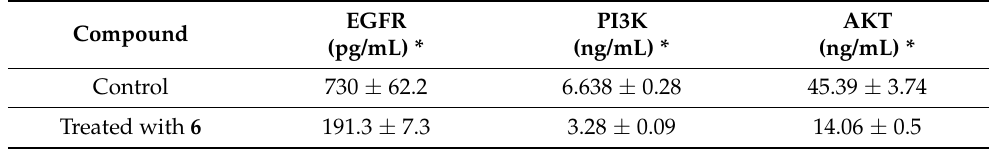
Table 3. Activity of tested compound 6 against EGFR, PI3K, and AKT pathways in MCF-7 cells. Compound Control